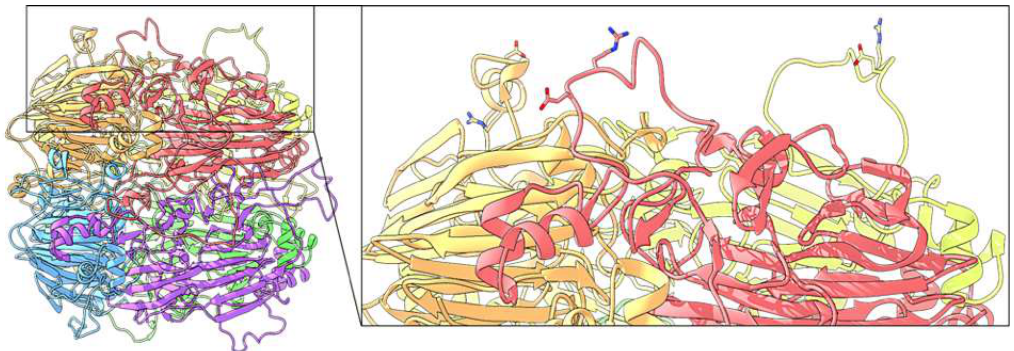
Figure 7. Predictive 3D structure of the homo-hexamer AAS67036 chenopodin. In the magnification panel on the right, a detail shows the surface locations of RGE sequences, one for each monomer, as stick representations.